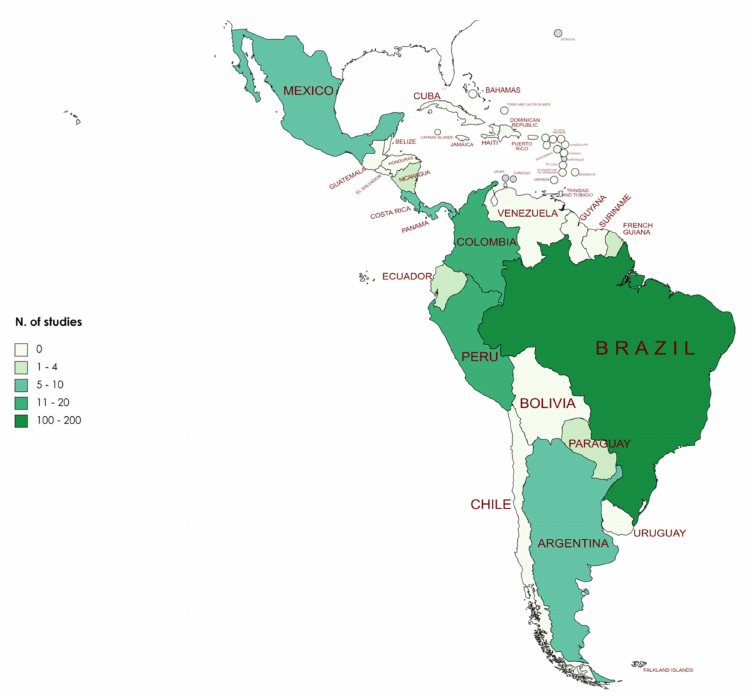
Figure 2. Geographical distribution of parasitological studies and number of studies per country and non-human primate